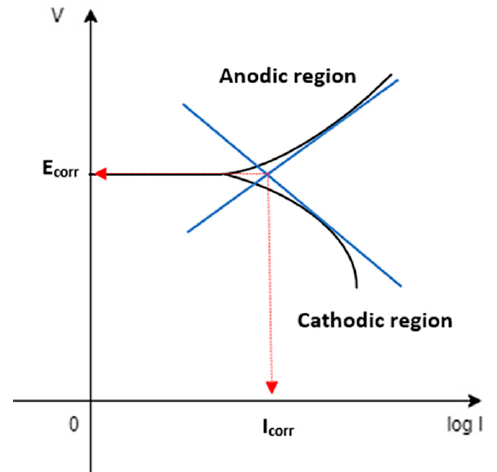
Figure 3. Tafel plot.